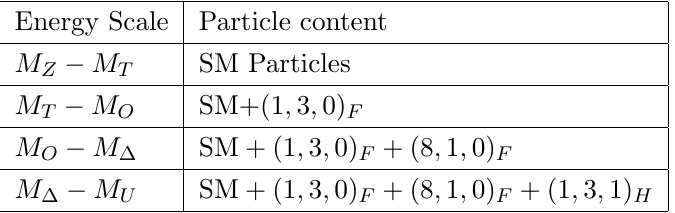
Table 2 . Particle content of the model in di(cid:11)erent ranges of mass scales.